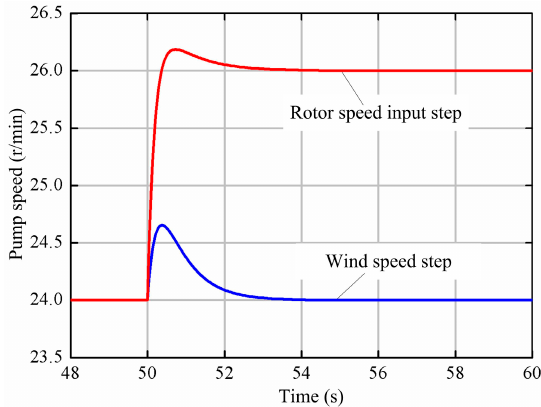
Figure 10. Pump speed.